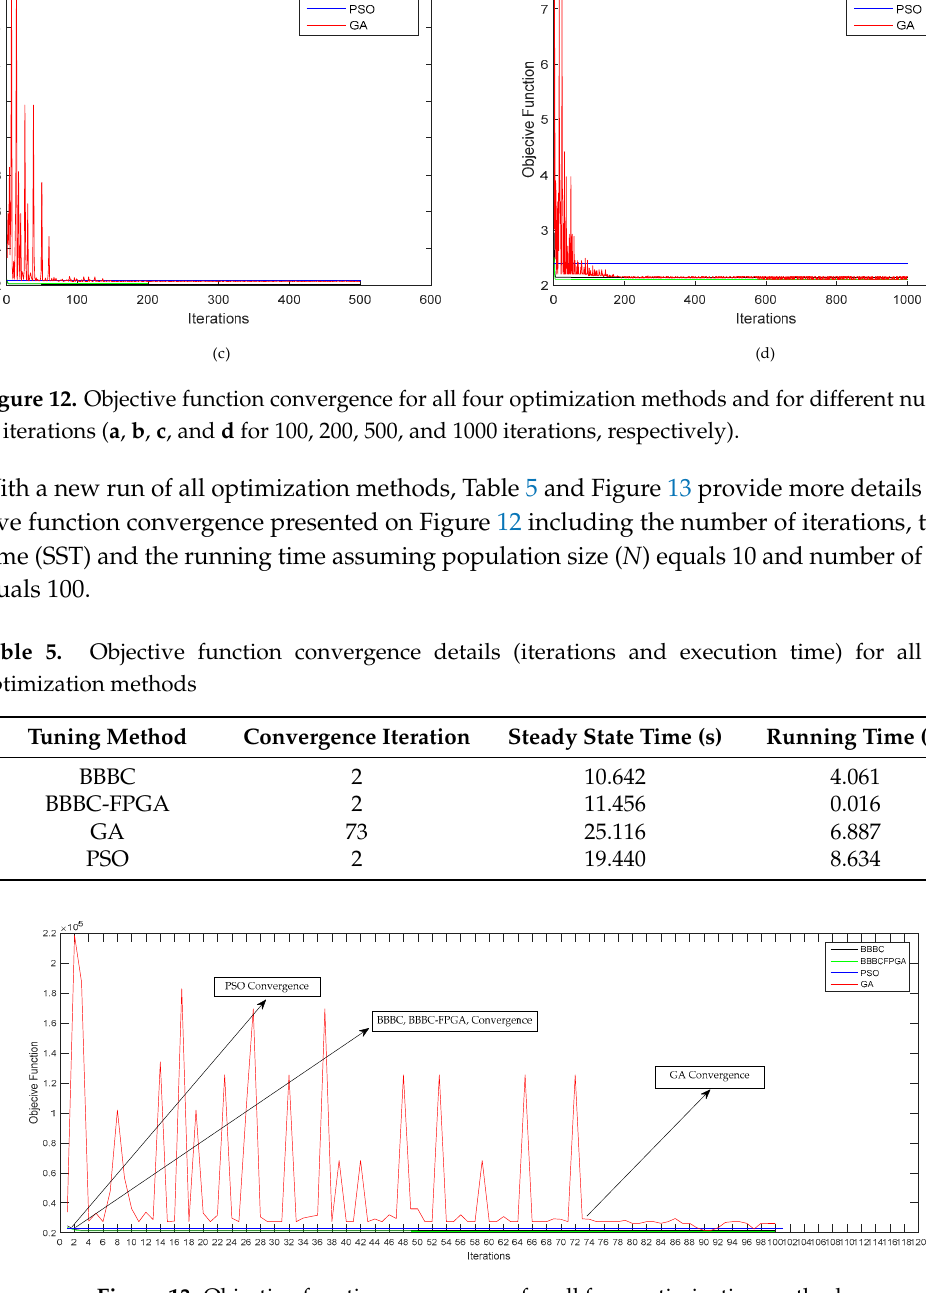
Figure 13. Objective function convergence for all four optimization methods.